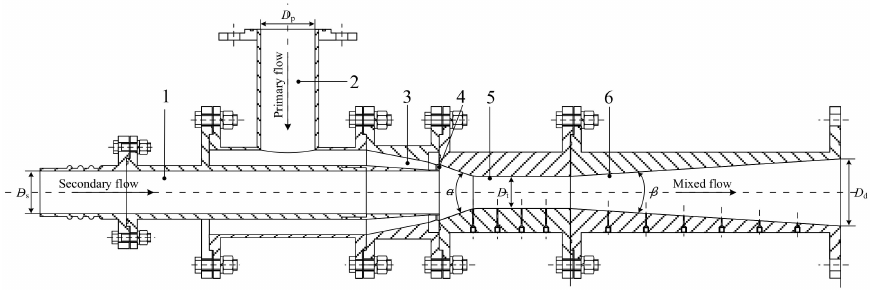
Figure 1. Sketch of jet fish pump structure. 1-suction duct; 2-primary duct; 3-suction chamber; 4-annular nozzle; 5-throat; 6-diffuser.